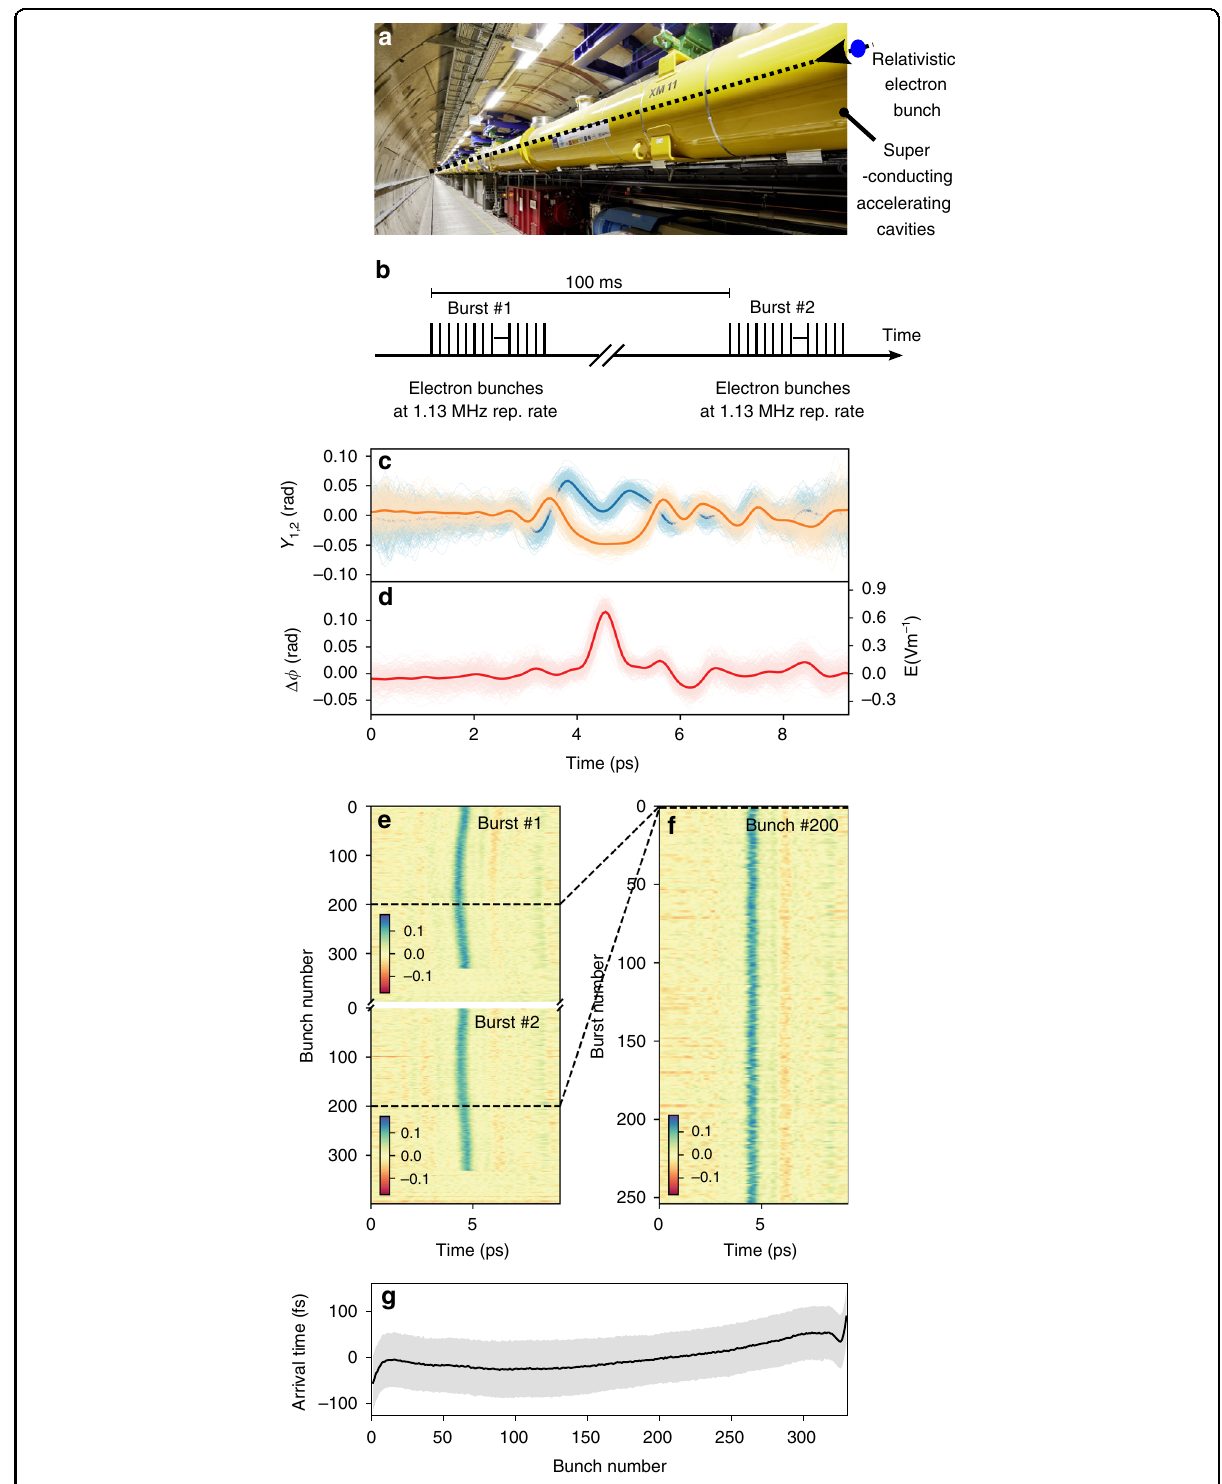
Fig. 5 Electron bunch shapes recorded at the European X-ray Free-Electron Laser (EuXFEL). a Picture from inside the 3 km-long accelerator tunnel. Our DEOS setup (see Fig. 6) is placed just upstream of the picture, after the fi rst bunch compressor. b Timing of the electron bunches in the conditions of the experiment. c Electro-optic signals Y 1,2 of a single bunch before reconstruction. d Reconstructed electric fi eld. Shaded areas: superposition of single-shot curves, color curves: average over 255 bursts. e Electro-optic signal of two bursts (i.e., 800 electron bunches in total). f Shape of one bunch (with bunch number 200 within the burst) versus burst number. g Arrival time versus bunch number. Shaded areas: RMS arrival time fl uctuations, color curve: average over 255 bursts. The EO data are low-pass fi ltered to 2.5